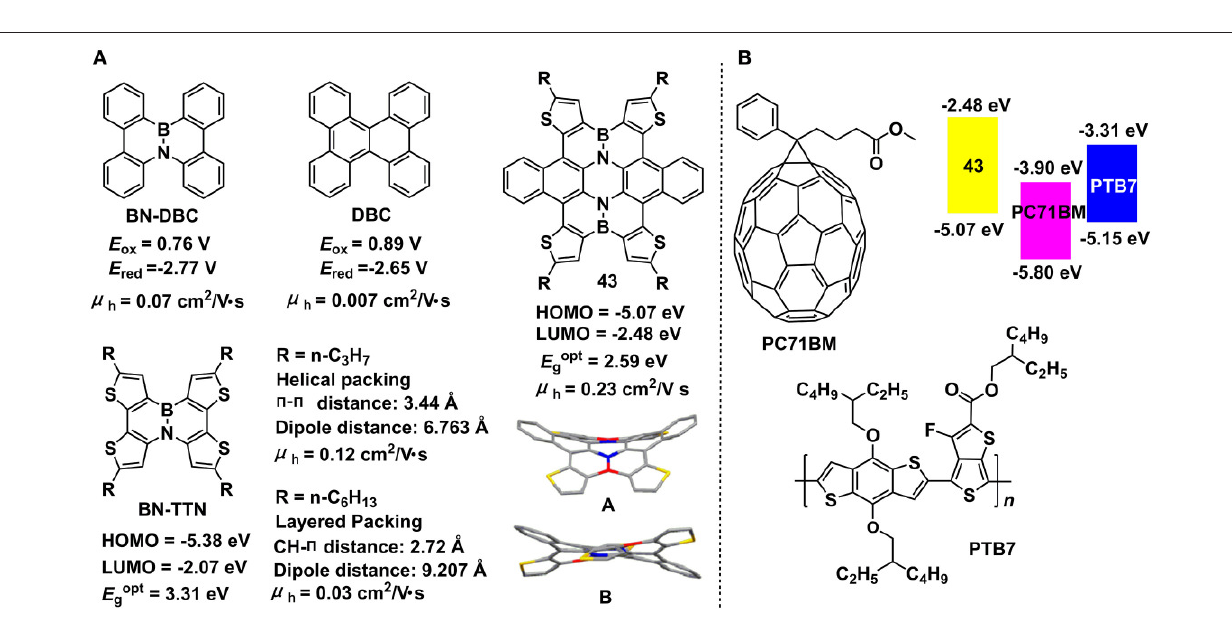
leading to stronger electronic coupling between neighboring molecules. Pei and co-workers developed two BN-substituted tetrathienonaphthalene derivatives, i.e., BN-TTN-C3 and BN- TTN-C6 (Wang X. et al., 2013). Because of the different side chains, the two BN embedded units exhibited distinct packing mode, with helical and layered packing style for BN-TTN-C3